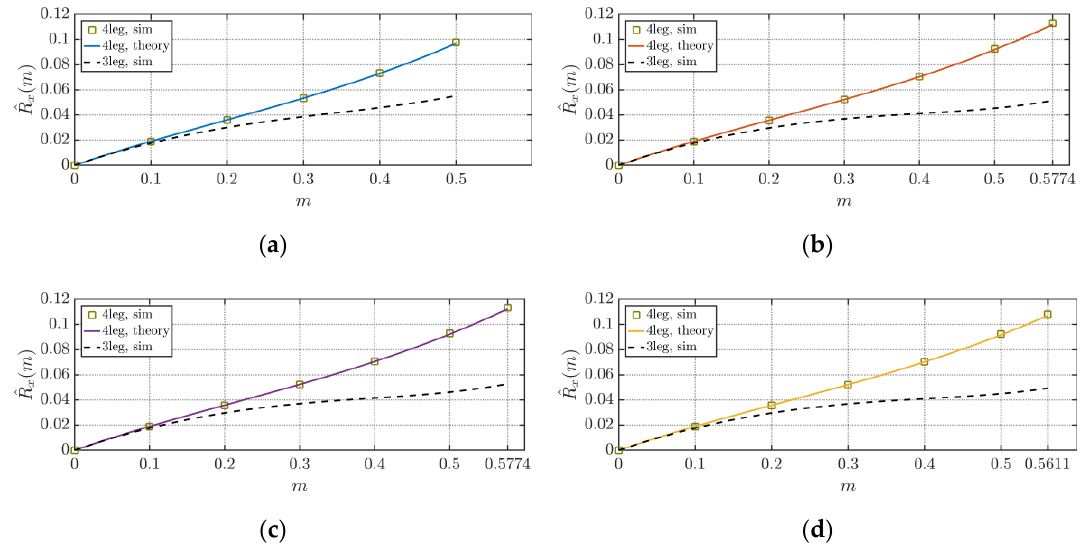
Figure 23. Normalized current ripple rms as a function of m for: ( a ) SPWM; ( b ) CPWM; ( c ) THIPWM1/6; and ( d ) THIPWM1/4.